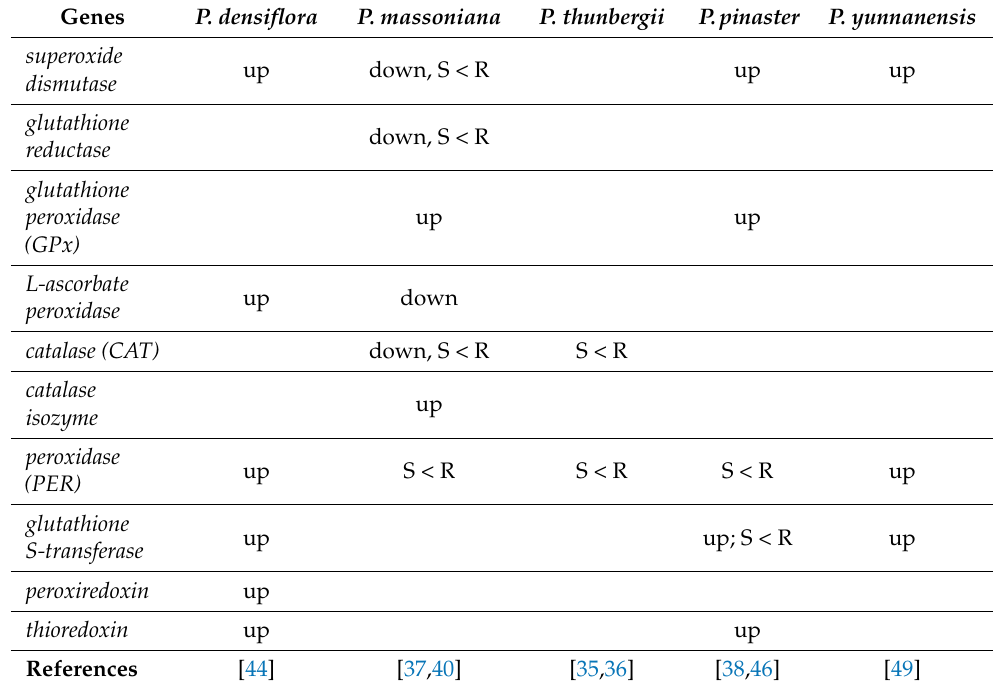
Table 4. Expression of oxidative stress response genes that encode enzymes involved in detoxification of reactive oxygen species (ROS) after pinewood nematode inoculation in several pine species.